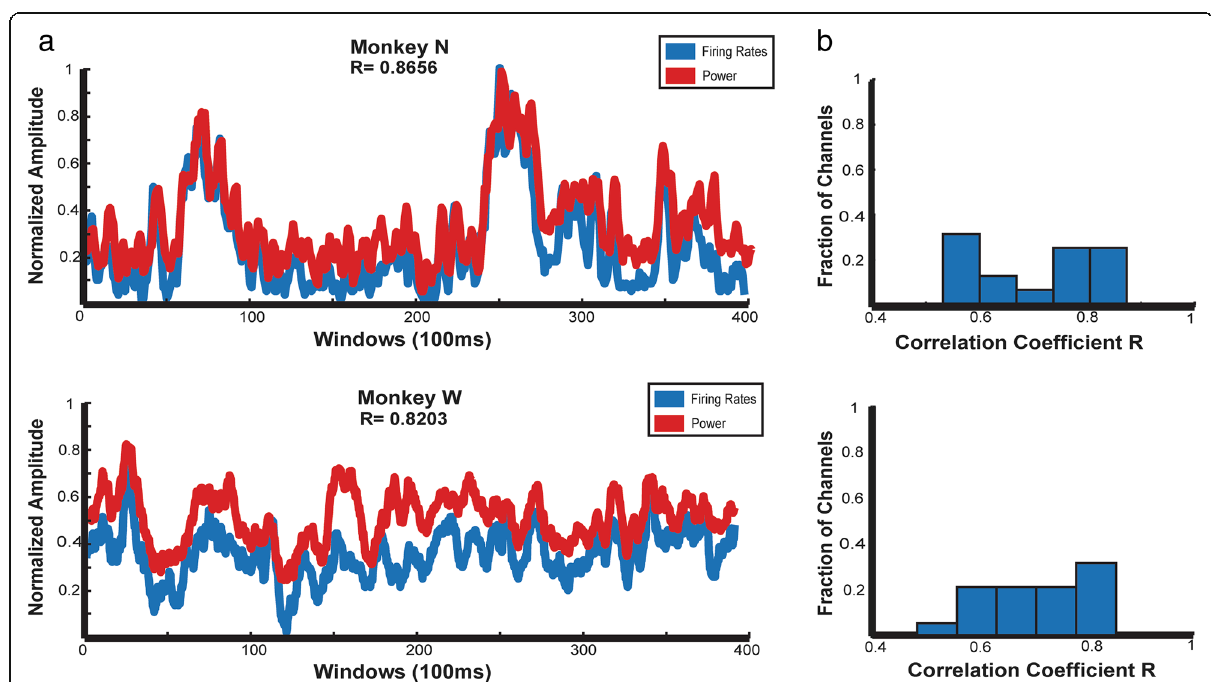
Fig. 10 a Comparison of mean spiking band power from the device normalized to the maximum power and firing rate calculated offline normalized to the maximum firing rate over 100 ms windows for the best single channel. b Histograms of the correlation coefficients for all channels in the dataset